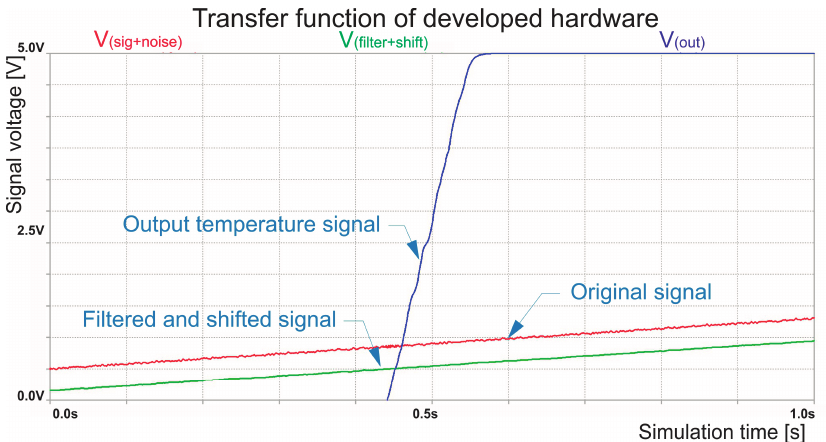
Figure 7. Temperature’s sensor transfer